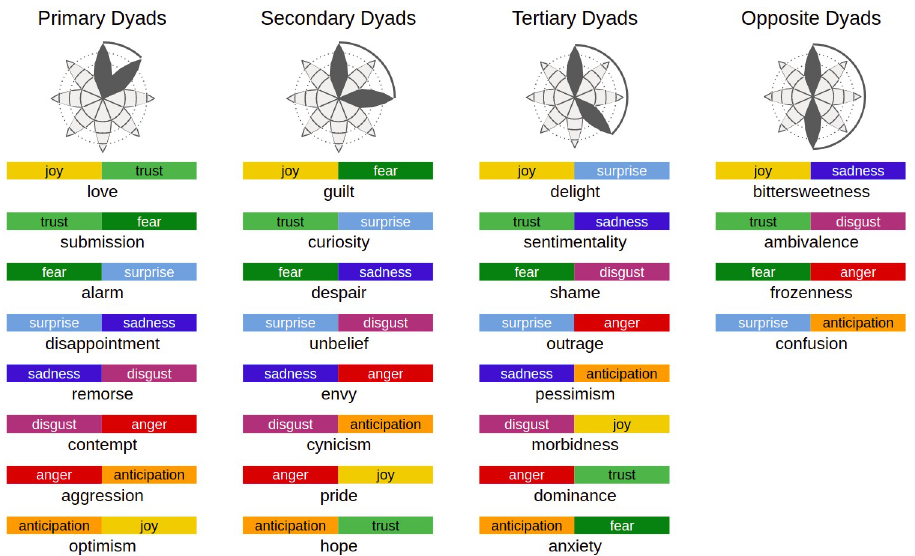
Fig 3. Diagram of Plutchik’s dyads. When two emotions are elicited together, they trigger the corresponding primary dyad if they are just one petal apart, a secondary dyad if they are two petal distant each other, a tertiary dyad if they are three petal distant, an opposite dyad if they are on the opposite side of the